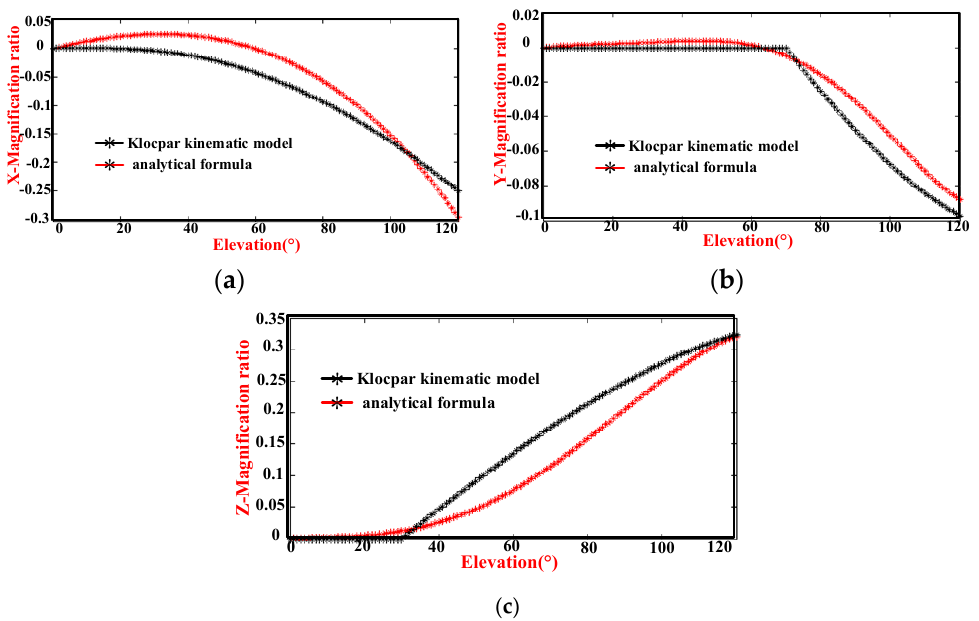
Figure 12. Comparison of the magnification ratio of the GH joint center displacement variable quantity relative to the thorax coordinate system during humeral elevation in the coronal plane and the Klop č ar kinematic model: ( a ) translational displacement variable quantity x bdi and x( Φ ), ( b ) translational displacement variable quantity y bdi and y( Φ ), and ( c ) translational displacement variable quantity z bdi and z( Φ ).